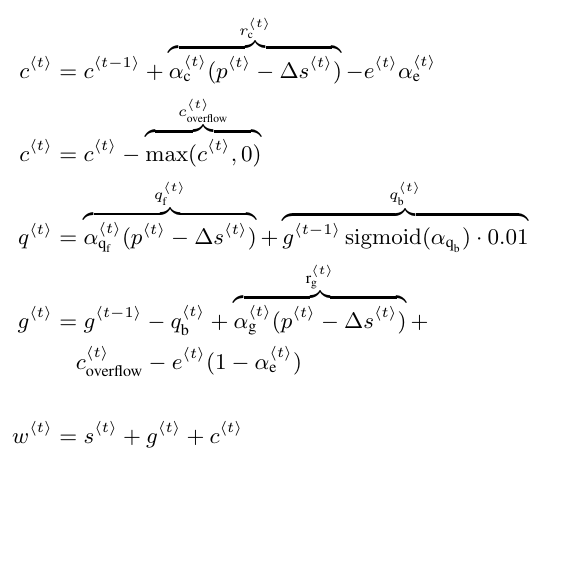
The hydrological block implements water balance equa- tions. The physical state variables g and c are updated at each time-step using a combination of the above latent vari- ables and variables derived here. When c = 0 , the soil is fully water-saturated, negative values indicate a water deficit. If c > 0 , the soil capacity is exceeded and over- flow occurs ( c overflow ). Note that for the model evaluation, c is transformed such that a deficit is denoted by positive val- ues. The base runoff (Q b , q b ) is defined as g times a learned . The total runoff (Q, q ) is the sum of global fraction α q b q b and q f . The total water storage (TWS, w ) anomalies are calculated as the sum of s , g , and c , minus the mean of w to get the variation around 0 . The units are mm for state variables and mm d − 1 for